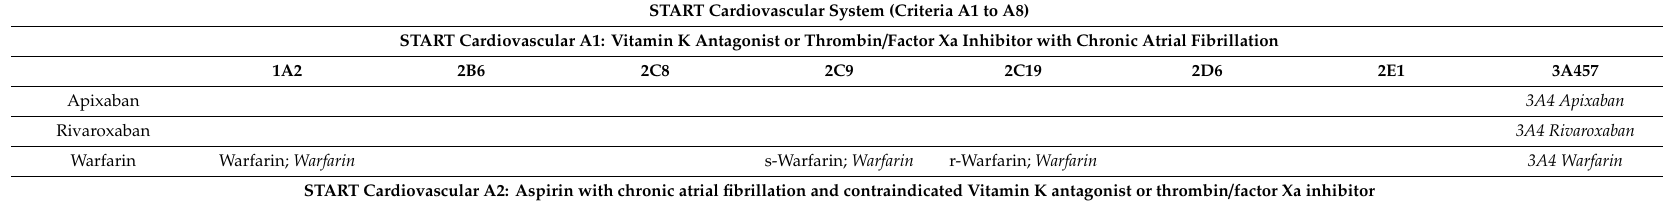
START Cardiovascular A2: Aspirin with chronic atrial fibrillation and contraindicated Vitamin K antagonist or thrombin / factor Xa inhibitor Aspirin > 325 mg / d also CYP 2J2, 2U1, START Cardiovascular A3: Antiplatelet therapy with coronary, cerebral, or peripheral vascular disease Aspirin > 325 mg / d also CYP 2J2,